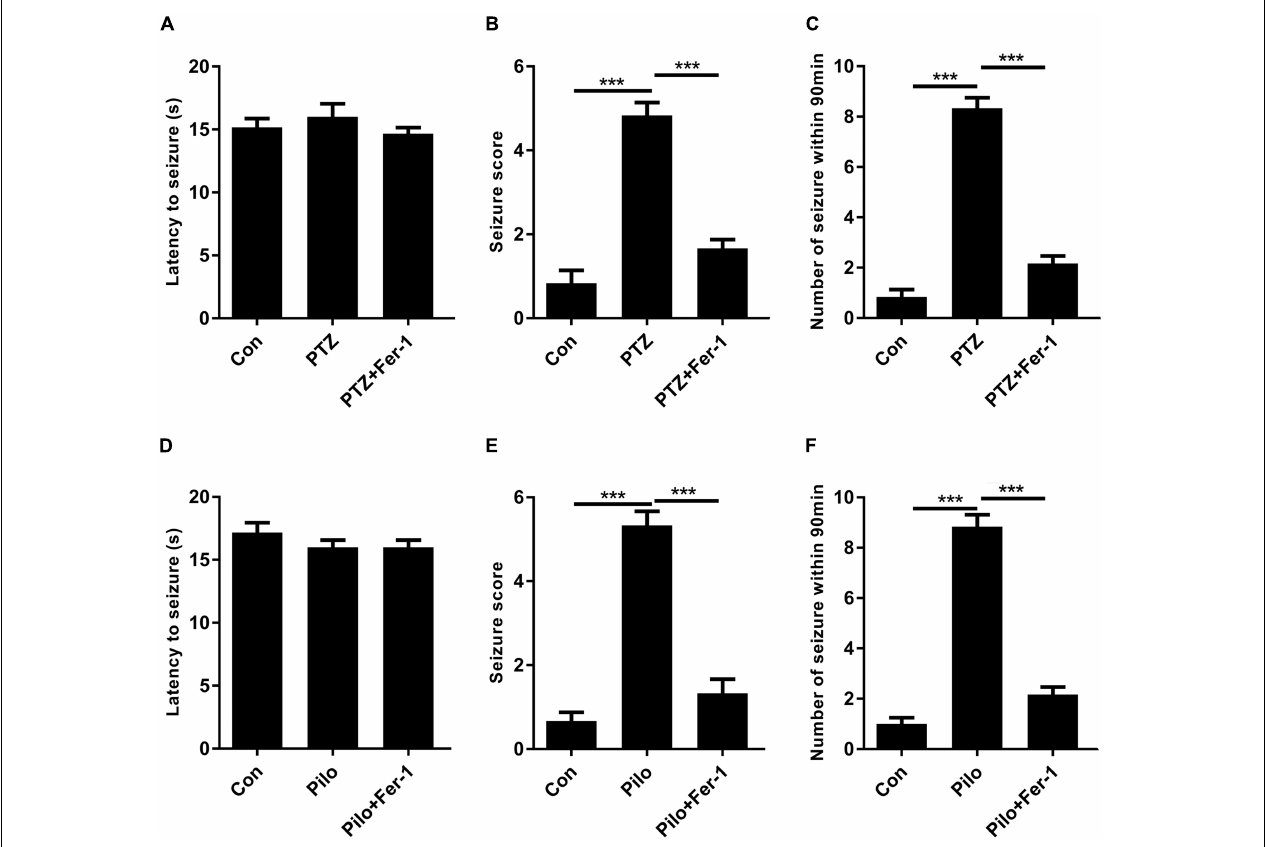
FIGURE 2 | Fer-1 alleviates PTZ kindling or Pilo-induced seizures in mice. (A–C) Evaluations of latency to seizures, seizure score and number of seizures within 90 min in PTZ-treated mice after Fer-1 treatment. (D–F) Evaluations of latency to seizures, seizure score, and number of seizures within 90 min in Pilo-treated mice after Fer-1 treatment ( ∗∗∗ p < 0.001, n =